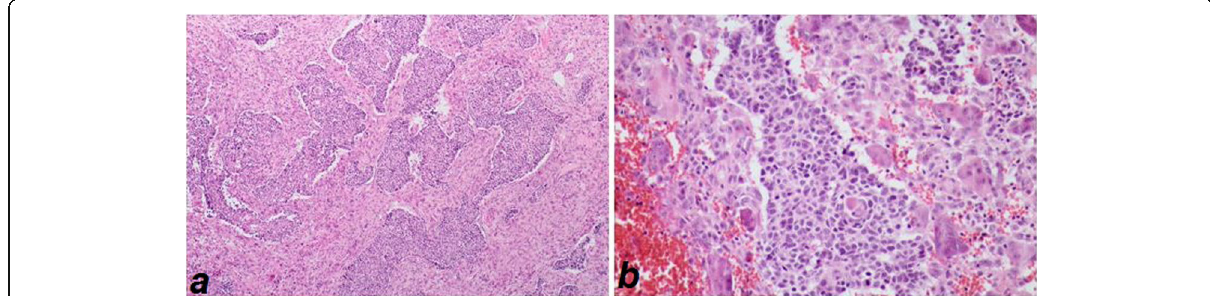
Fig. 1 Islands of undifferentiated carcinoma in the stroma with diffuse foreign body type granulomatous response, H&E stained